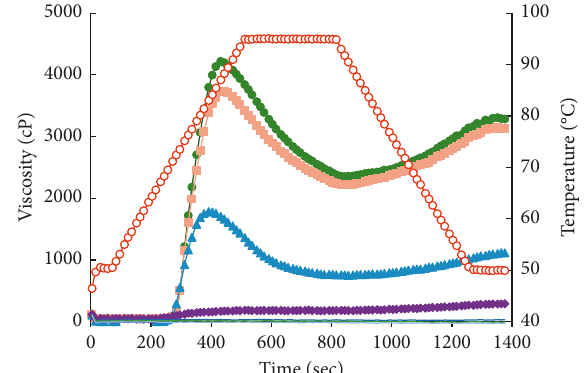
Figure 4: Rapid visco analyzer: raw and malic acid-treated sweet potato